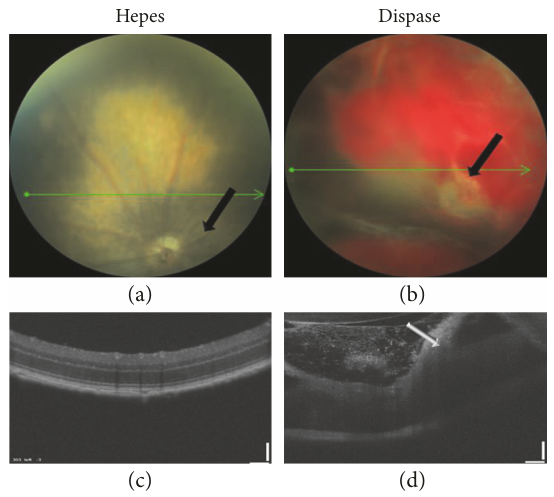
Figure 1: Funduscopy and OCT in mice eyes after dispase injection. Mice injected with Hepes only (control) demonstrated normal retina (a). Mice injected with dispase demonstrating RD with fi brotic tissue in front of the retina (b). Normal retina on OCT (c) and detached retina with loss of normal appearance of the retina